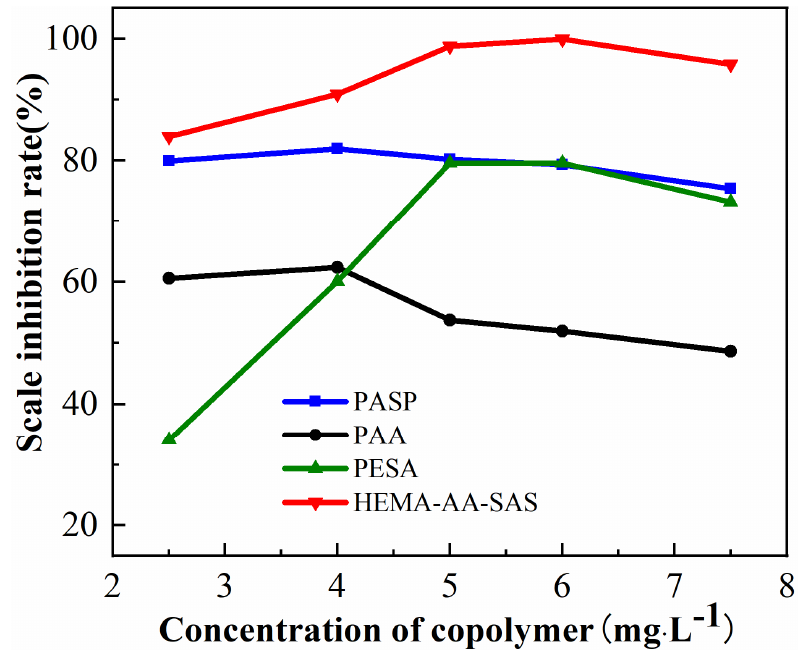
Figure 3. Influence of copolymer dosage on scale inhibition performance .